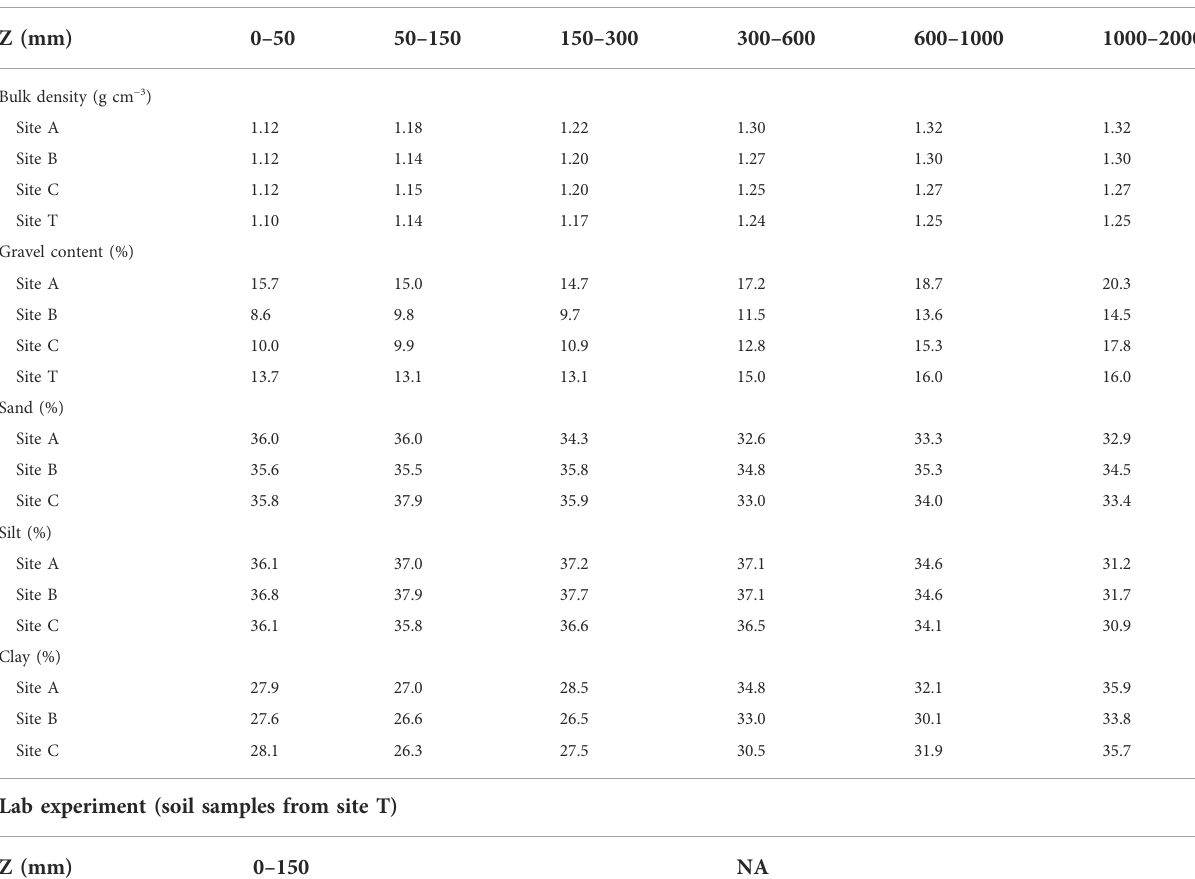
TABLE 1 The soil properties at sites A, B, C, and T from methods of SoilGrids 2.0 and lab experiment. SoilGrids 2.0